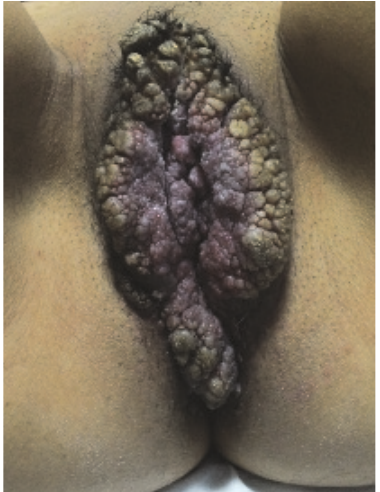
Figure 1: The appearance of Case 1 with distortion of labial and clitoral anatomy.